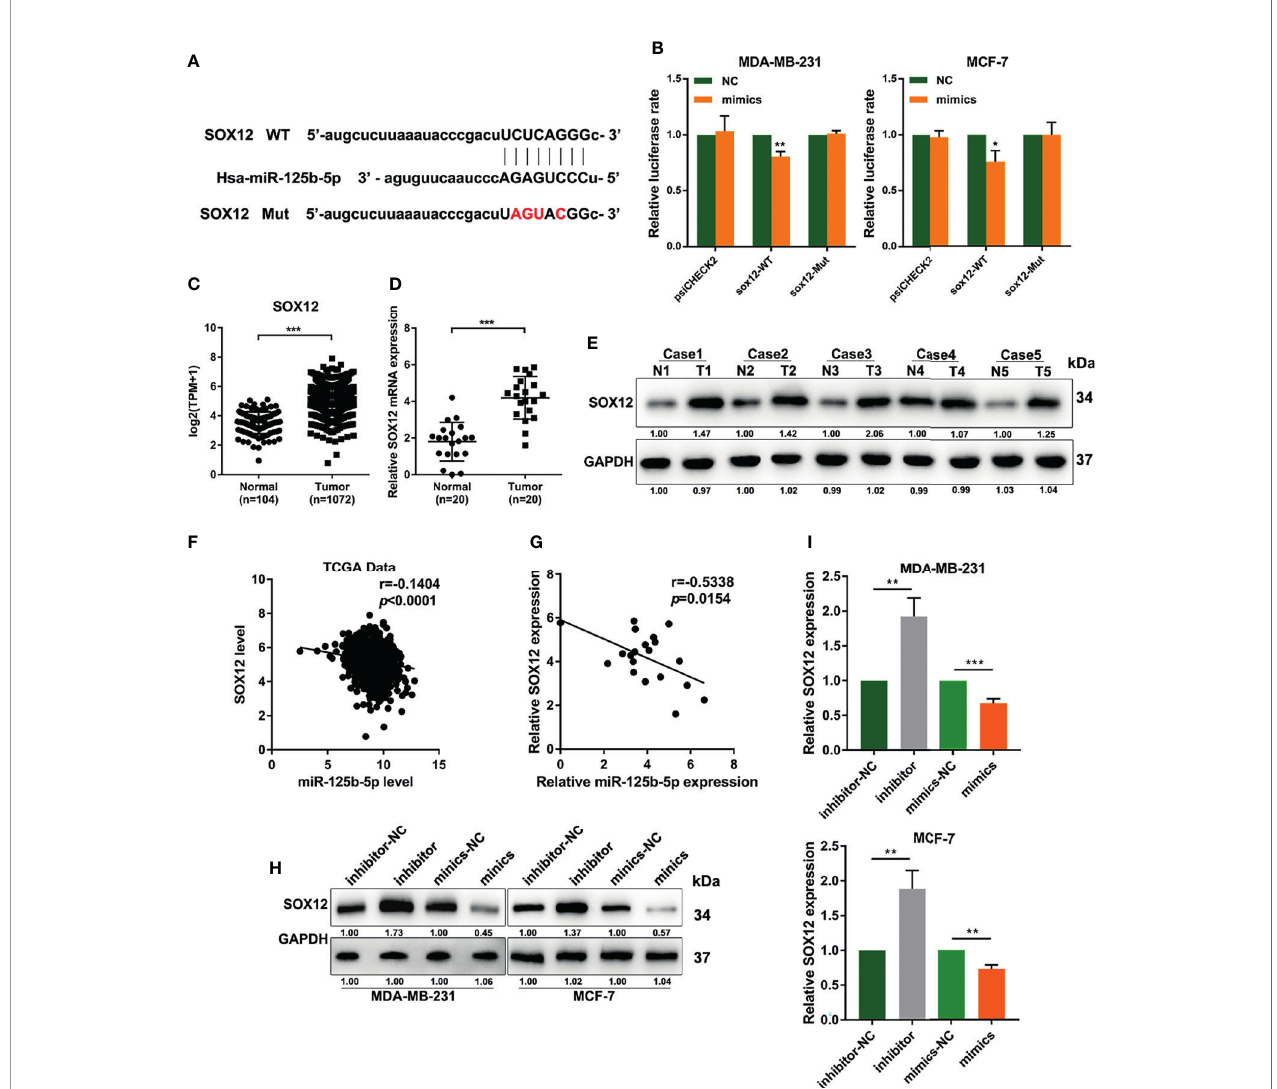
FIGURE 5 | miR-125b-5p directly binds to the 3 ′ -UTR of CRABP2 and suppresses SOX12 expression in breast cancer cells. (A) Schematic diagram of the miR-125b-5p putative binding sites and mutant site in the 3 ′ -UTR of SOX12 predicted by bioinformatics. (B) Luciferase activities in MDA-MB-231 and MCF-7 cells after co-transfection of the SOX12 mutant or wild-type (WT) plasmid together with the miR-125b-5p mimics or miR-NC. (C) The expression of SOX12 was analyzed between tumor and normal tissues using the breast cancer gene (BRCA) dataset of The Cancer Genome Atlas (TCGA). (D, E) mRNA and protein expressions of SOX12 detected in breast cancer tissues and corresponding paracancerous tissues using RT-qPCR and Western blot assays. (F) Correlations between the expressions of SOX12 and miR-125b-5p in TCGA BRCA dataset. (G) Correlations between the expressions of SOX12 and miR-125b-5p in clinical breast cancer samples. (H, I) mRNA and protein expressions of SOX12 detected in MDA-MB-231 and MCF-7 cells with the miR-125b-5p mimics or inhibitor transfection. * p < 0.05, ** p < 0.01, *** p <